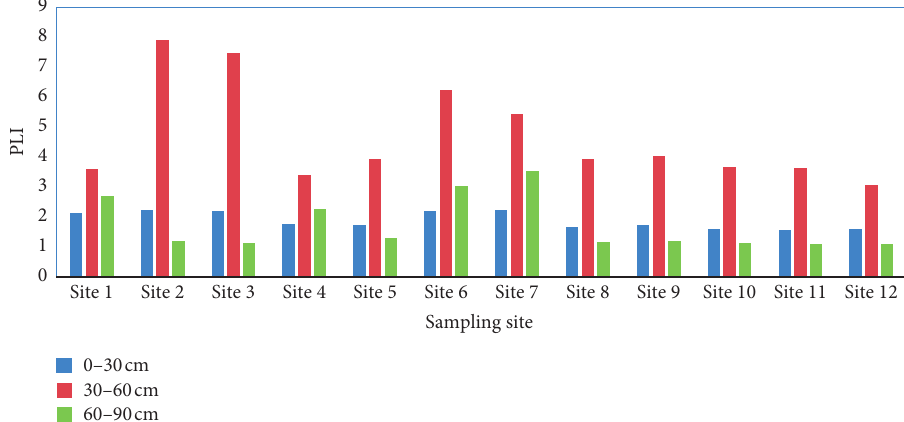
Figure 6: Pollution load index of the different sites around the